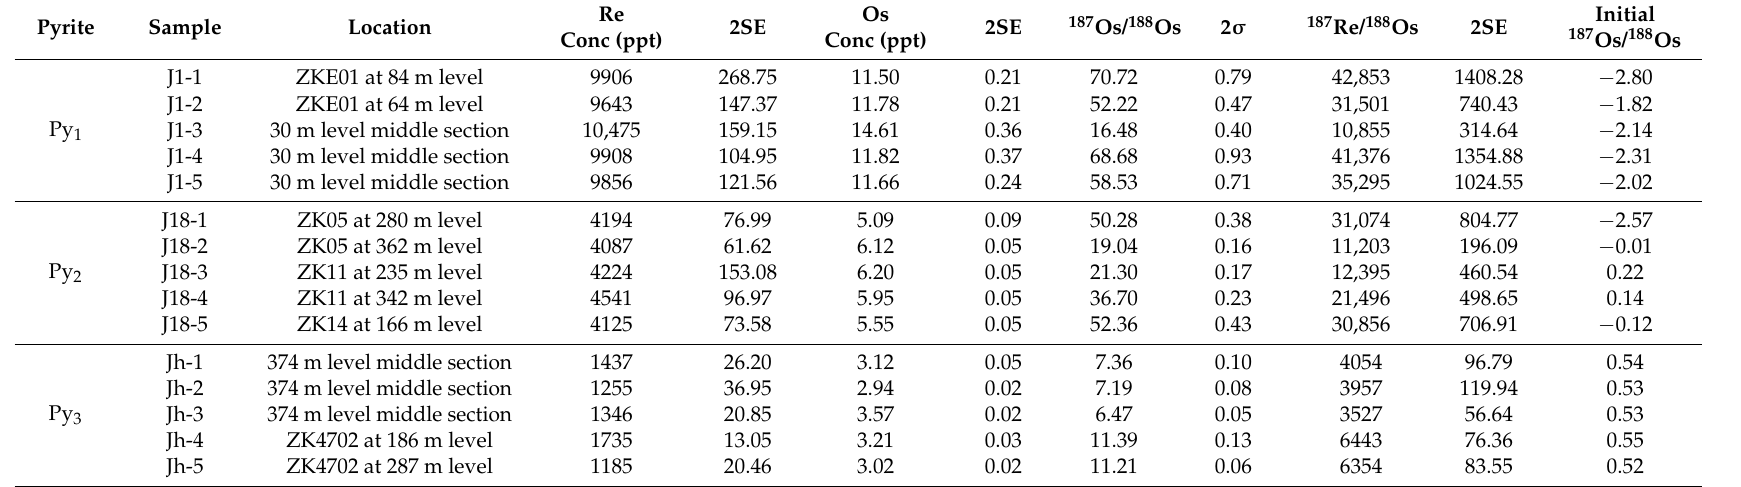
Table 1. Re–Os isotopic data for auriferous pyrites from various locations in the Jinchang gold